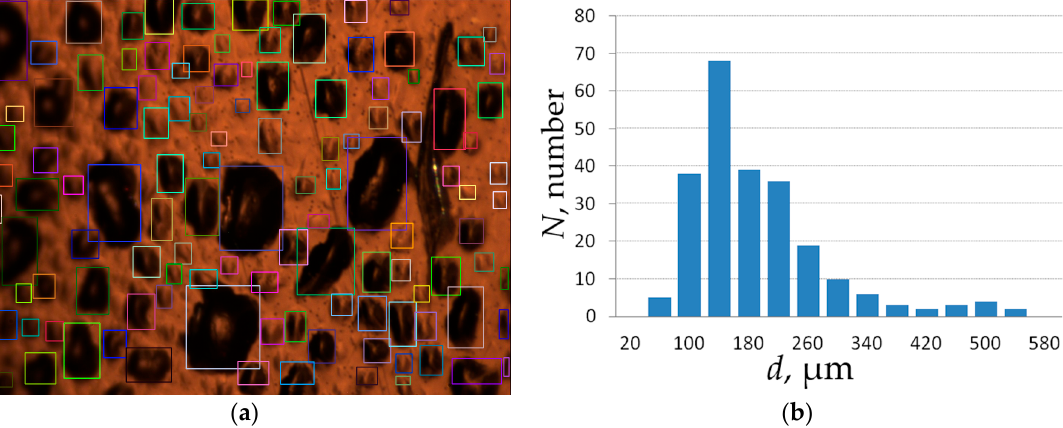
Figure 13. Result of image processing ( a ) and the size distribution histogram ( b ) of blisters on the surface of 99.99996% coarse-grained copper (Sample 2). The frame size is 9 mm horizontally and 4 mm vertically ( a ).